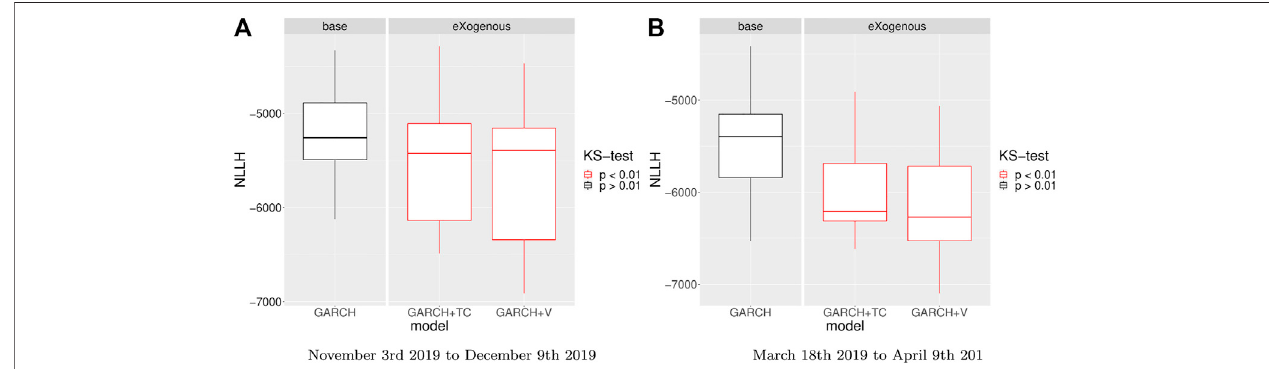
FIGURE A3 | Bootstrap robustness check over N (cid:1) 100 splitting points with T (cid:1) 1000 training points and T (cid:1) 1000 points in test size for GARCH and GARCHX models. The nonparametric Kolmogorov – Smirnov test of the equality of the NLLH out-of-sample distributions between GARCH and GARCHX models is done. (A) KS testimpliesasigni fi cantdifferenceforallexternalsignalsfortheGARCHmodelintheperiodfromNovember3rd,2019toDecember9th,2019with52,000observations. (B) KS test implies a signi fi cant difference for all external signals for the GARCH model in the period from March 18th, 2019, to April 9th, 2019, with 38,000